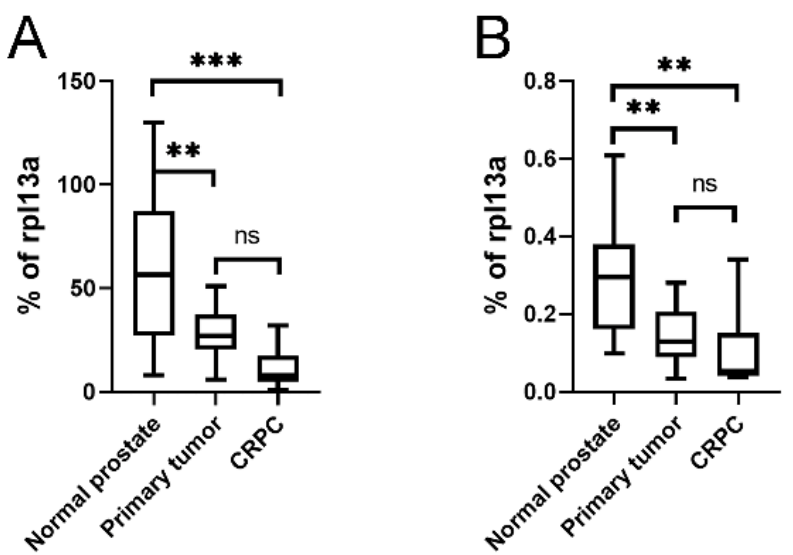
Figure 8. Expression of KLK4 and KLK4T2 transcript in patient material. Transcript levels were measured by RT-qPCR on unfractionated RNA prepared from normal human prostate tissue ( n = 10), primary PC tumor ( n = 13) or bone metastasis from CRPC patients ( n = 9). In the qPCR, the primer pairs KLK4Ne3f-KLK4Ne4r amplifying KLK4 ( A ) and K4T2e23f-K4T2e3r specific for KLK4T2 ( B ) were used. The results are given as concentration relative to the transcript concentration of the housekeeping gene rpl13a, which was amplified using primer pairs rpl13a-f–rpl13a-r. Samples were run as triplicates, and data are plotted as boxplots with the median value as a line across the box and the first quartile (Q1) value at the bottom and the third (Q3) at the top. The whiskers show the highest and lowest values in each group. *** p < 0.001, ** p < 0.01, ns = not significant.